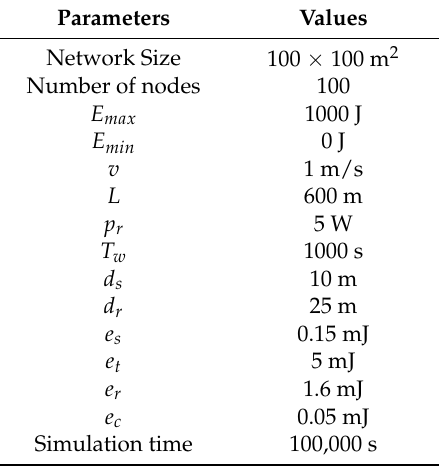
Table 2. Default parameters setting.